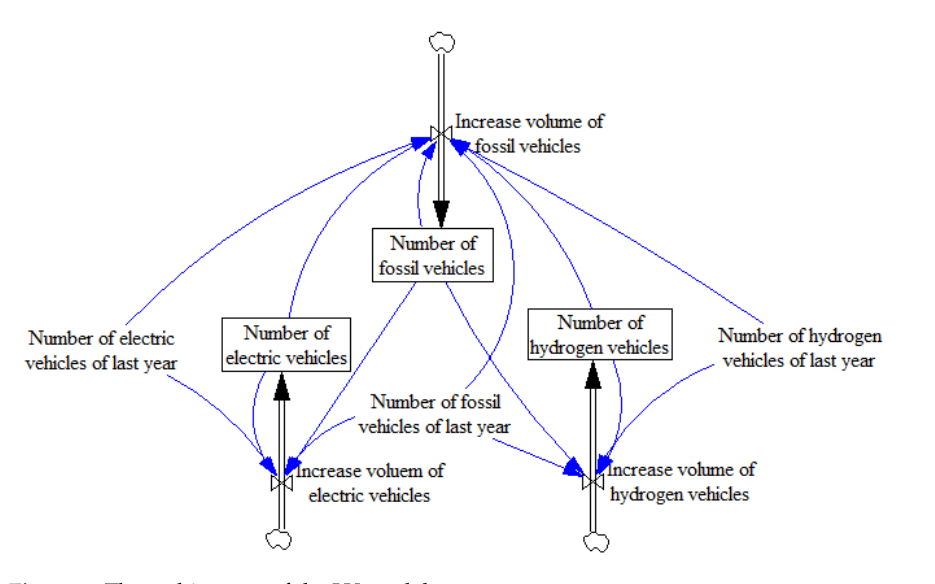
Figure 5. The architecture of the LV